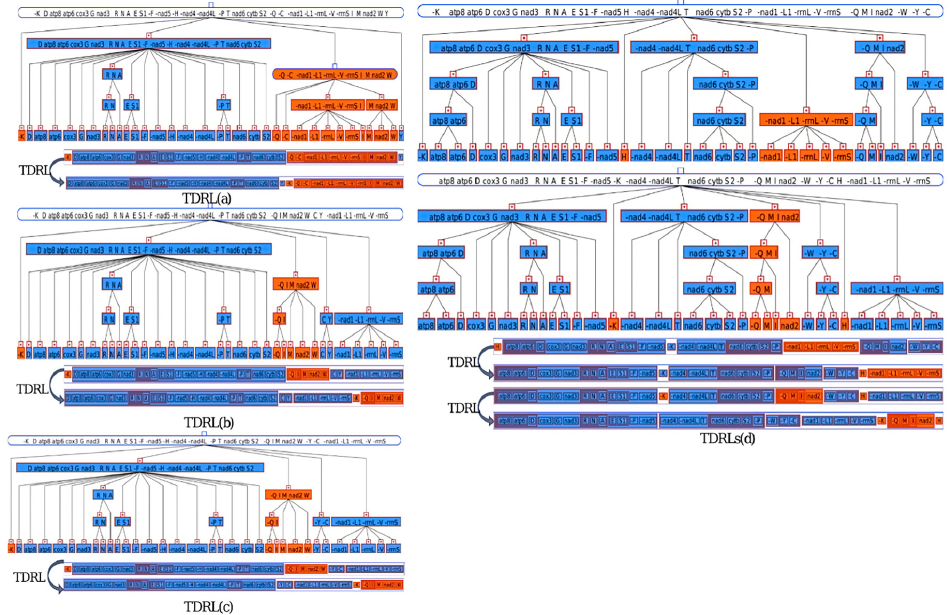
Figure 5. CREx estimated the scenario of mitochondrial gene order rearrangement (TDRLs) for the given phylogeny of the Balanomorpha order. Model 1 starts with the transposition of genes ( A, S 1 , and T ), followed by TDRL events of gene clusters ( nad1-L 1 -lrRNA-V-srRNA-I-Q-M-nad2-W-C ) which is different from the plesiomorphic pancrustacean arrangement. Consecutive copies of the gene cluster nad1-